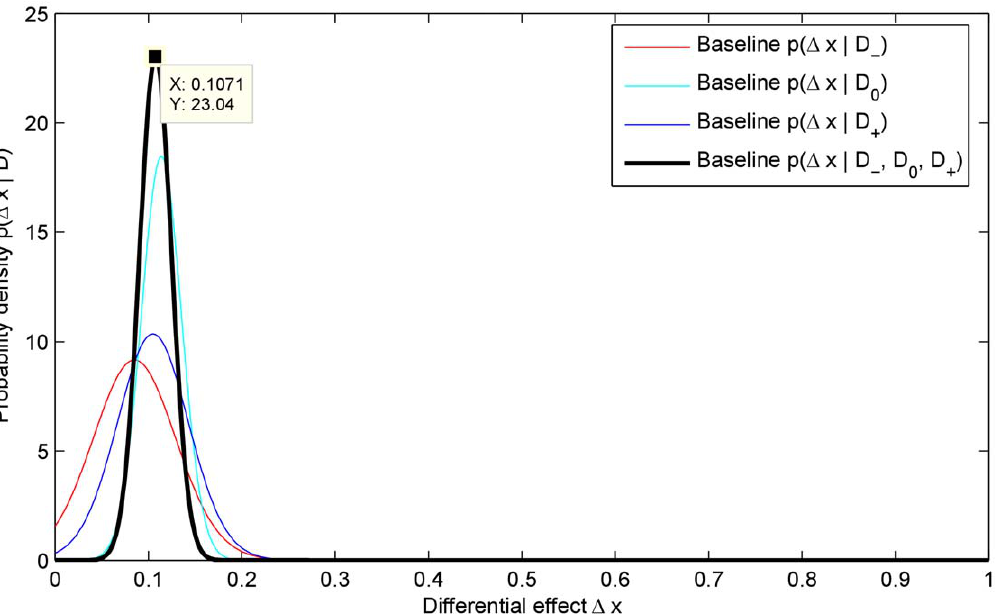
Figure 5. The three sub-group posteriors, p ( D x D D { ) , p ( D x D D 0 ) and p ( D x D D z ) , and the joint posterior p ( D x D D ) ~ p ( D x D D { , D 0 , D z ) . Also marked is the mode of the posterior D x (cid:3) ~ arg max D x p ( D x D D ) & 0 : 107 .